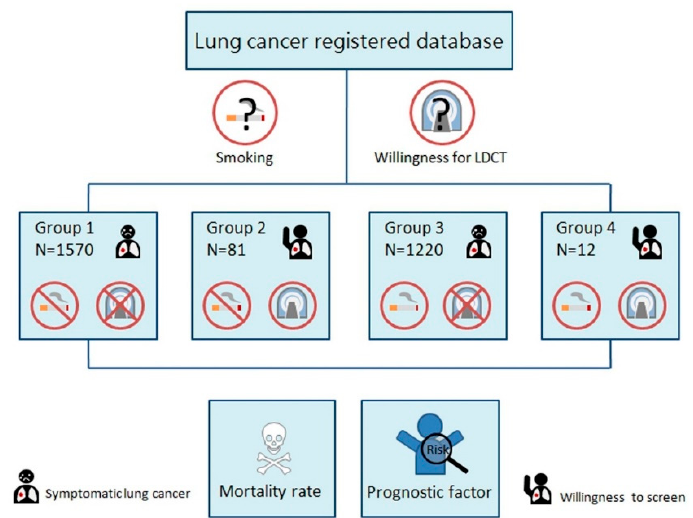
Figure 1. Flowchart of patient recruitment. Patients were classified into four groups according to smoking and screening status. Table 1. Demographic features of enrolled subjects for group (N = 2883) comparison based on smoking and screening status (means, standard deviations, and ANOVA results).